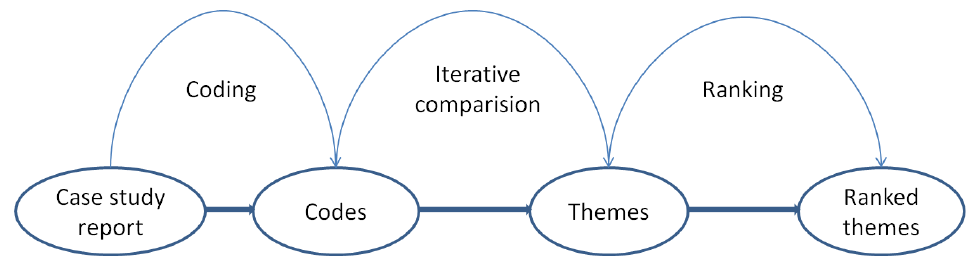
Figure 1. Thematic analysis process (authors own illustration).